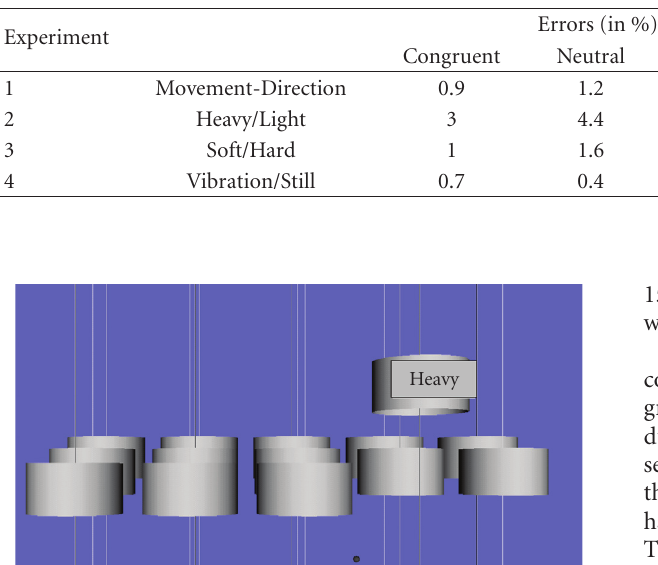
Table 1: Percentage of incorrect responses and RTs for the correct responses.